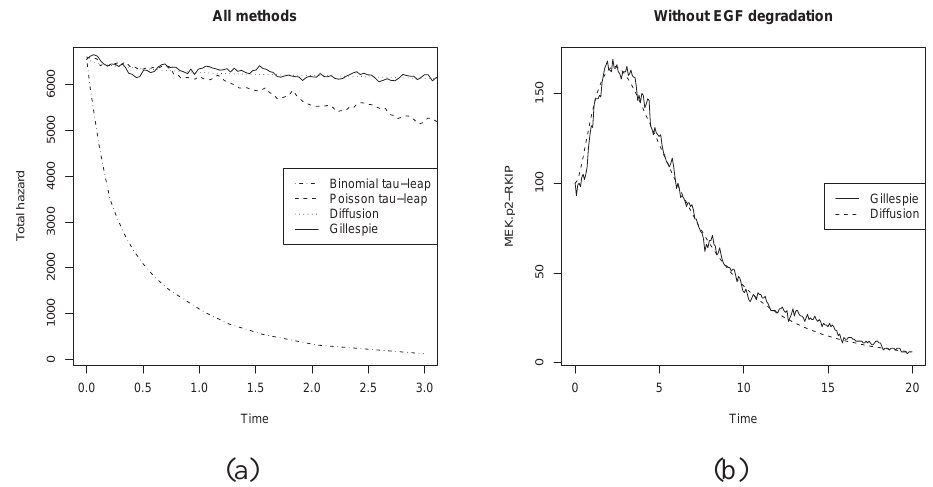
Figure 2: (a) Total hazards of Gillespie algorithm, Poisson τ -leap method with δ = 0 . 6 , Binomial τ -leap method with f = 10 2 , and diffusion approximation with new update plan under the first scenario and t = 5 . (b) Gillespie and diffusion approximation with new updating regime of active MEK-RKIP complex in cytosol under the first scenario and t = 20 . The y -axis indicates the number of molecules of this complex for the time t